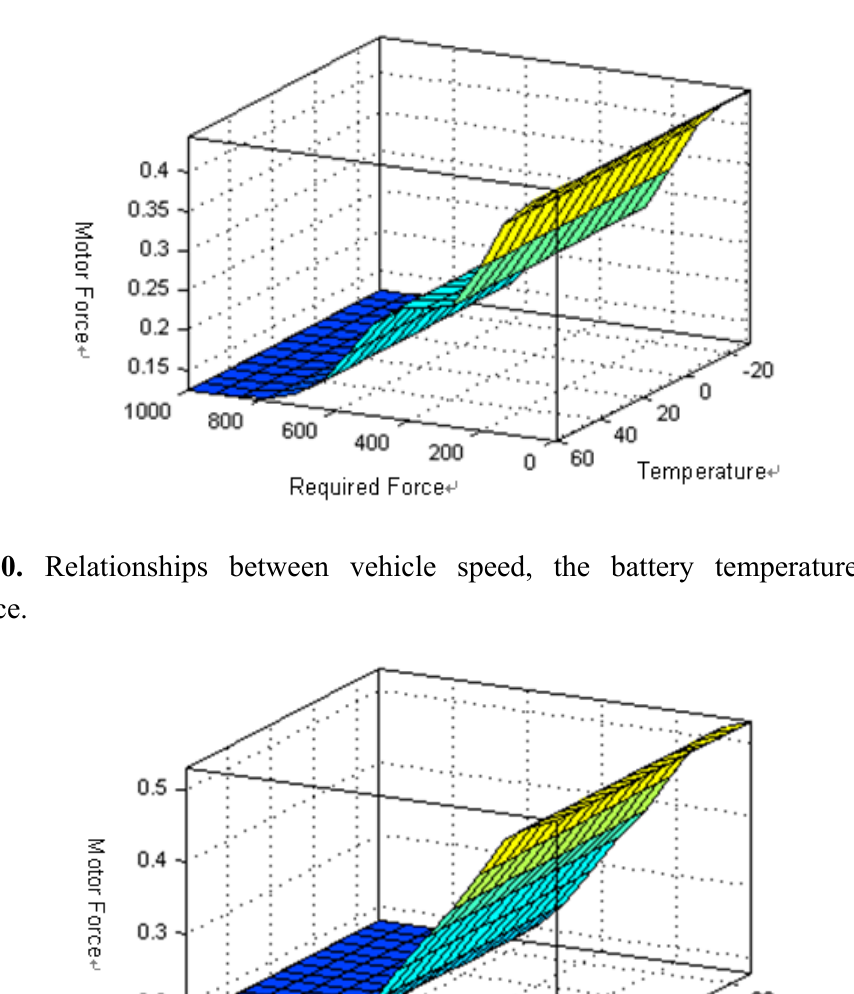
Figure 9. Relationships between driver’s braking force command, the battery temperature and motor force.